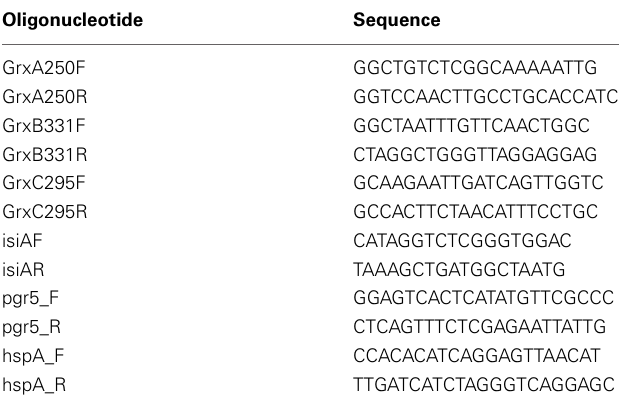
Table 2 | Oligonucleotides used in this work. Oligonucleotide